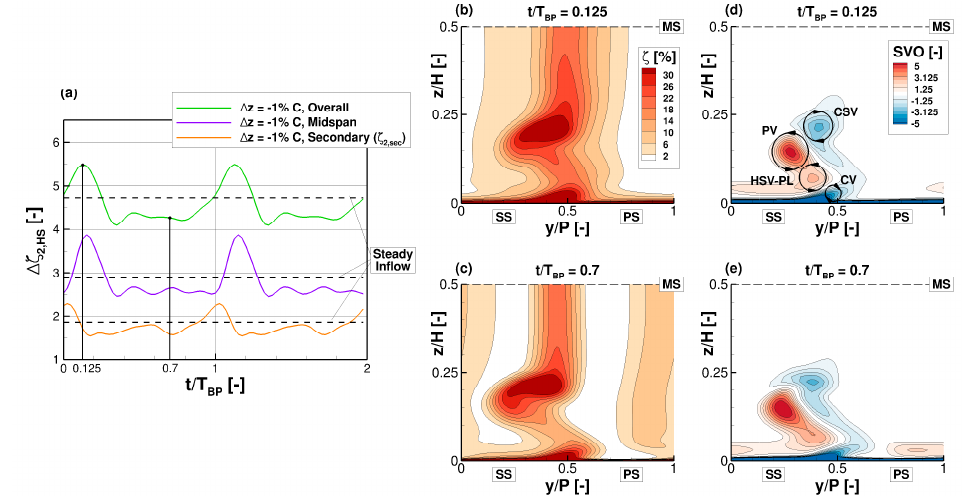
Figure 23. Numerical prediction of the change in ( a ) integral- and ( b , c ) local total pressure losses as well as ( d , e ) streamwise vorticity over time in MP2 with unsteady inflow conditions.